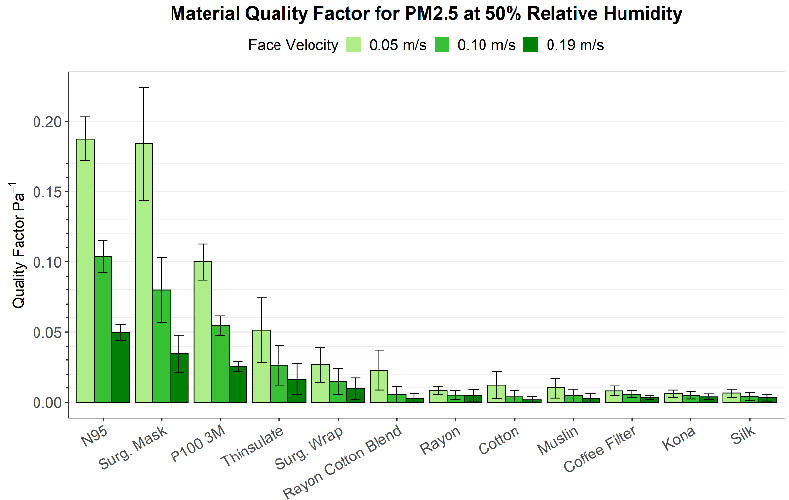
Figure 7. Quality factors for single-layered materials when face velocity is varied. Error bars in the figure represent the standard deviation across these three quality factor values, while the bar colors represent the corresponding face velocity values.